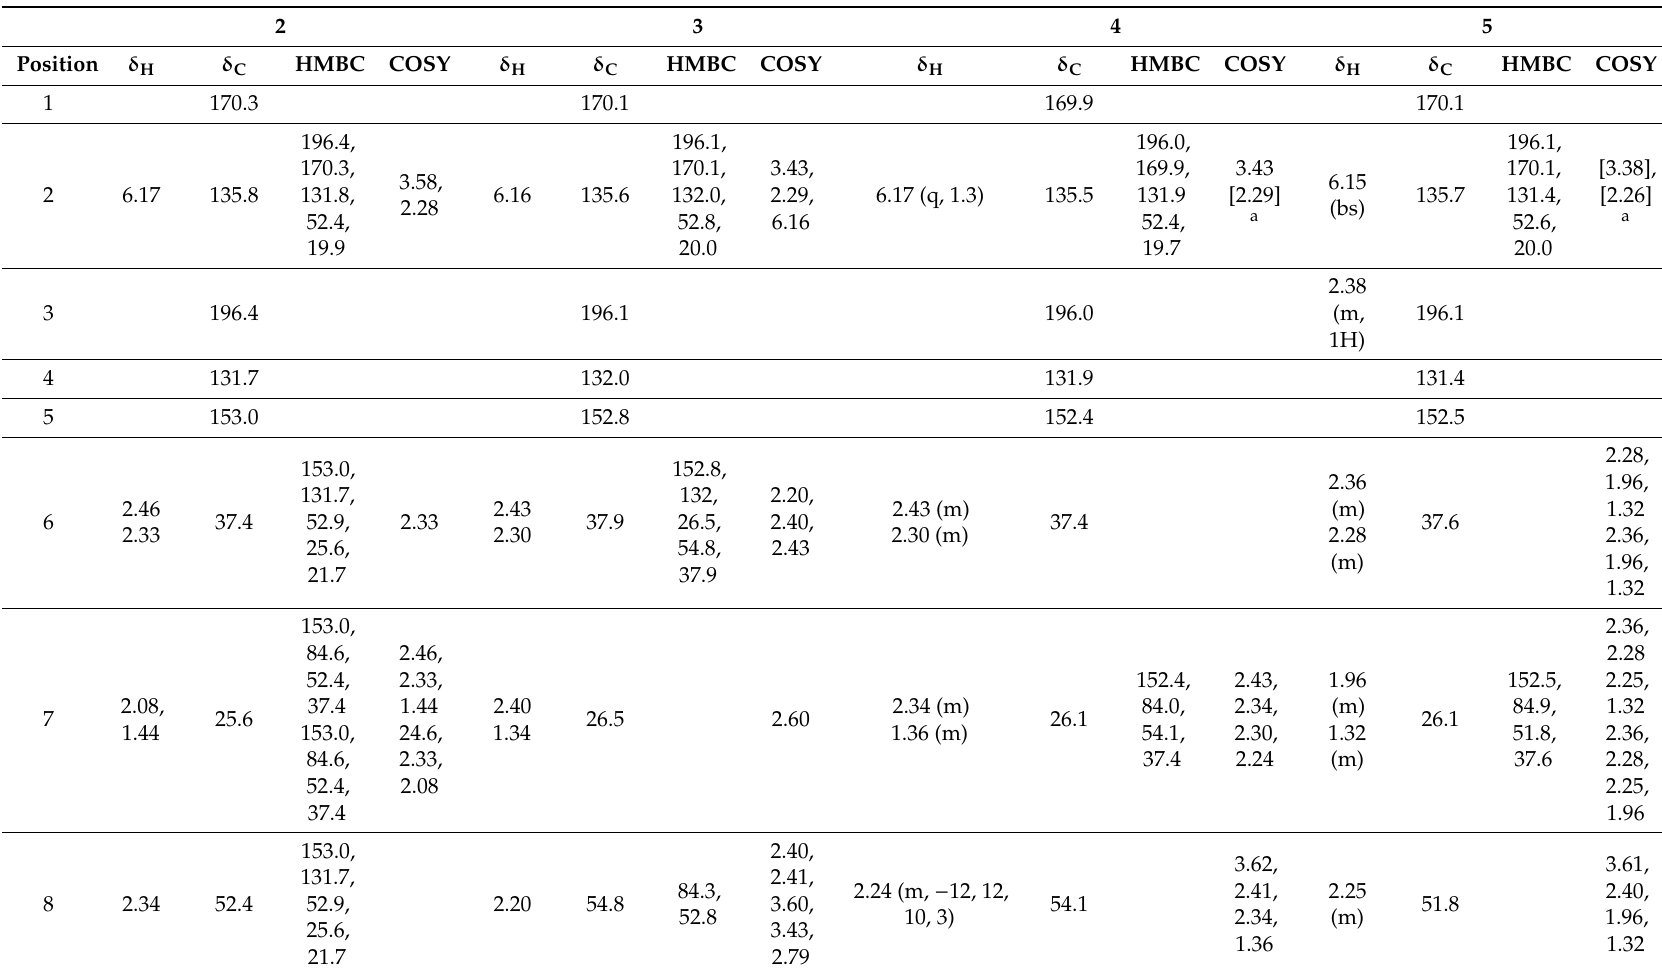
Table 1. NMR Spectroscopy Data (500 MHz, CDCl 3 ) of compounds 2 – 5